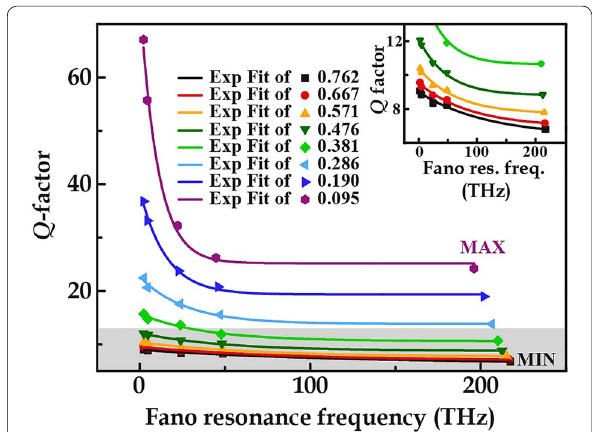
Fig. 5 Numerically evaluated Q -factor plotted against the Fano reso- nance frequency which is fitted with an exponential decay function. The inset shows the magnified view of the grey shaded area where the plots for higher asymmetry parameters are presented